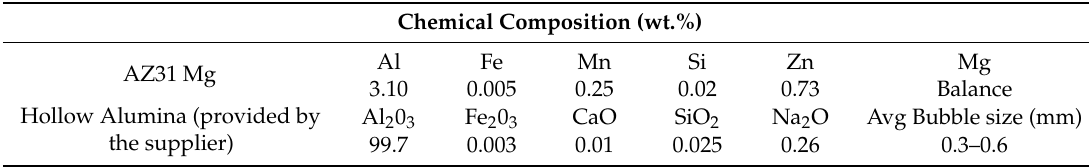
Table 1. Chemical composition of matrix and